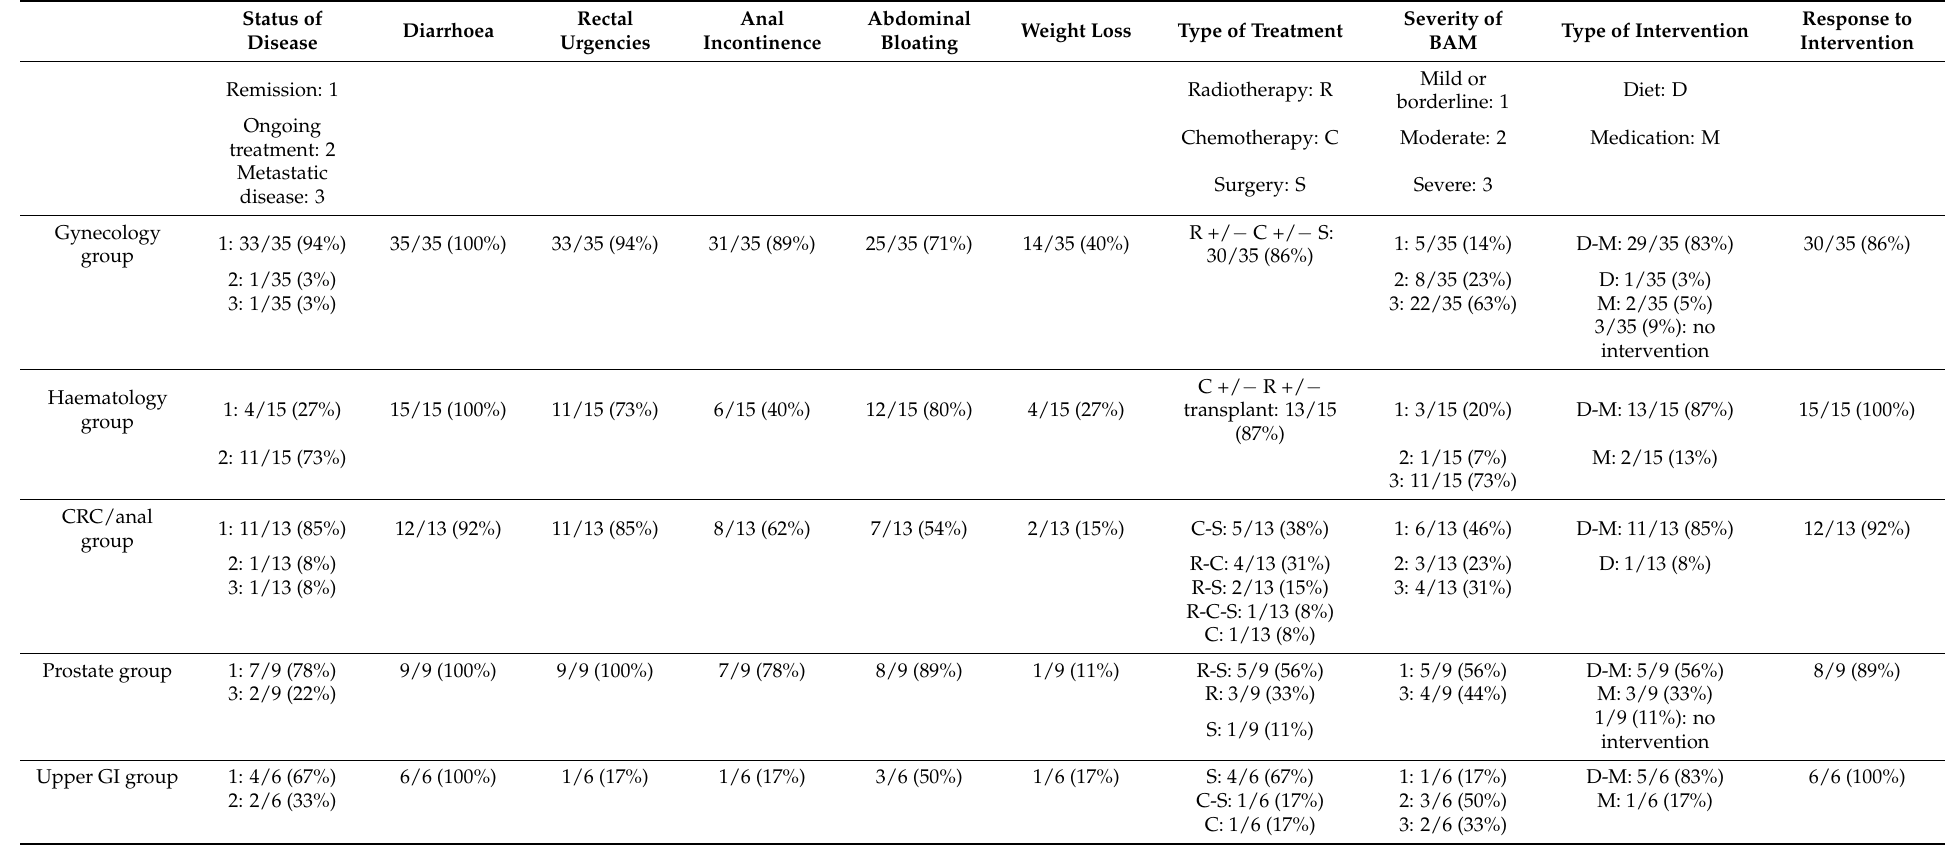
Table 1. Clinical and radionuclide